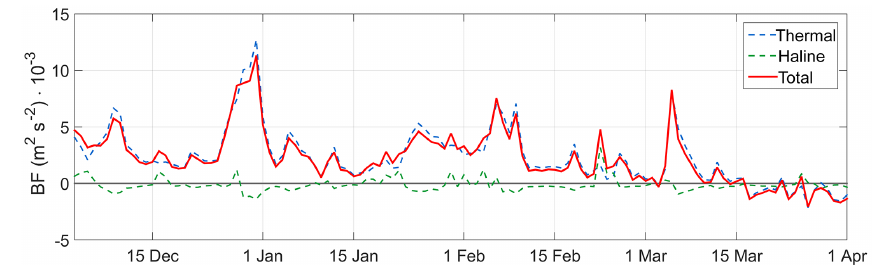
Figure 12. Daily integral values of surface buoyancy fluxes (BFs) and its components averaged over the nested model domain.